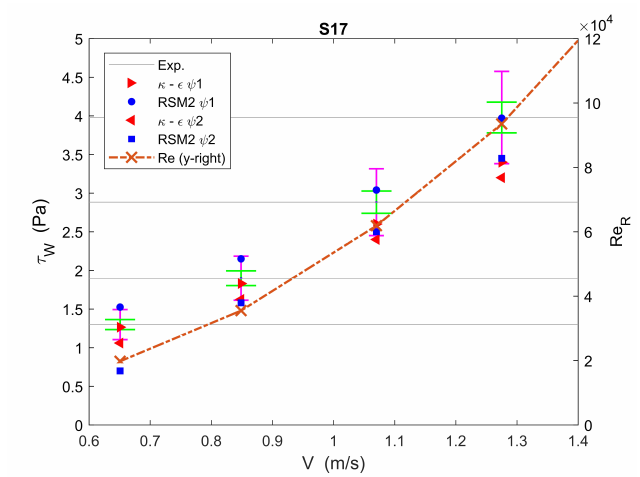
Figure 9. τ y = 0.16 Pa, m = 0.0328 Pas n , n = 0.6043 and D = 100 mm.